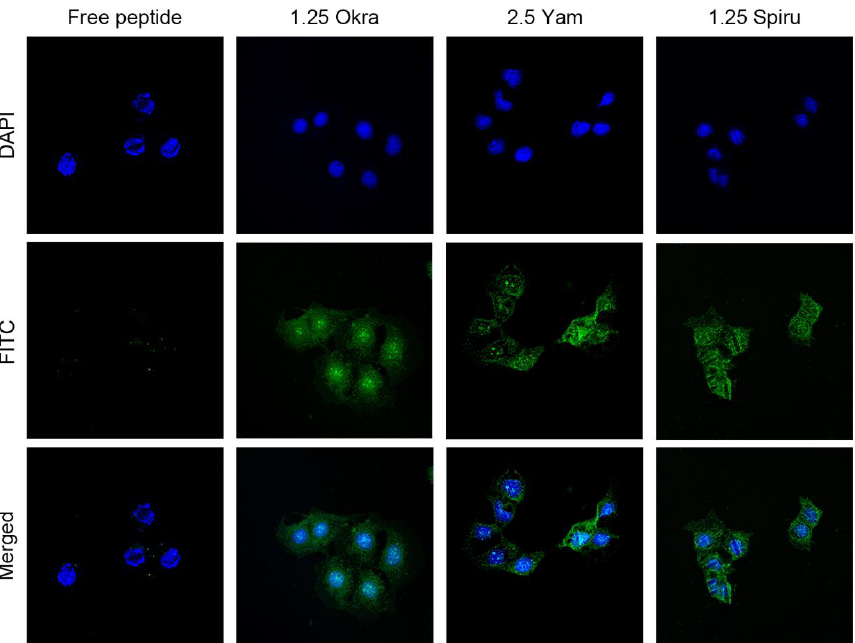
Figure 5. Peptide uptake by Caco- 2 cells in vitro. A total of 100 μL of 0.2 mg/mL free FITC-modified peptide or peptide-loaded double emulsion was added and incubated for 2 h at 37 °C. LSCM was employed to observe the FITC-labeled peptide uptake by Caco-2 cells. Nuclei: blue; FITC-labeled peptides: green. The green-fluorescence-labeled peptides that appeared within the cytoplasm con- firmed the sufficient cellular uptake of the peptide drugs.